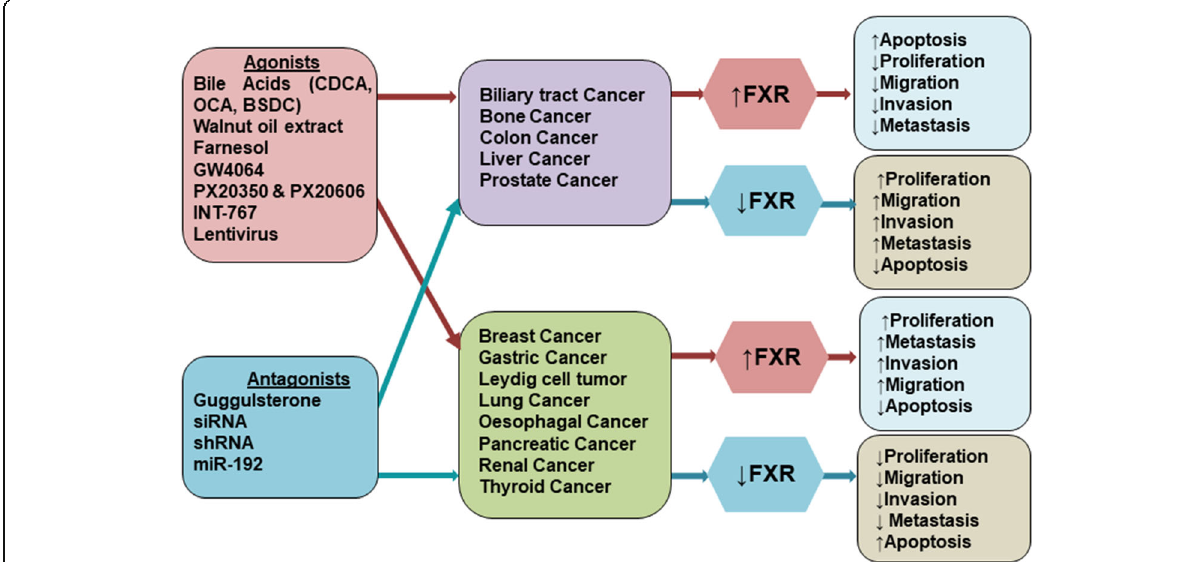
Fig. 3 Role of agonists and antagonists in different cancers. The FXR is downregulated as compared to basal level in colon, liver, prostate, bone and biliary tract cancers and the treatment with FXR agonists increase the expression of FXR that leads to inhibition in proliferation, migration, and invasion of cancer cells, and induction of apoptosis. While in other cancers with overexpressed FXR such as breast, gastric, Leydig cell, lung, oesophagal, pancreatic, renal and thyroid cancers, the treatment with agonists increases FXR that results in high proliferation, migration, and invasion, and suppression of apoptosis of cancer cells. Conversely, the treatment with FXR antagonists in FXR-downregulated cancers, it further decreases the expression of FXR that results in induction of proliferation, migration, and invasion, and inhibition of apoptosis. While in FXR- overexpressed cancers, the treatment with antagonists inhibits FXR and decreases the proliferation, migration, and invasion, and induces